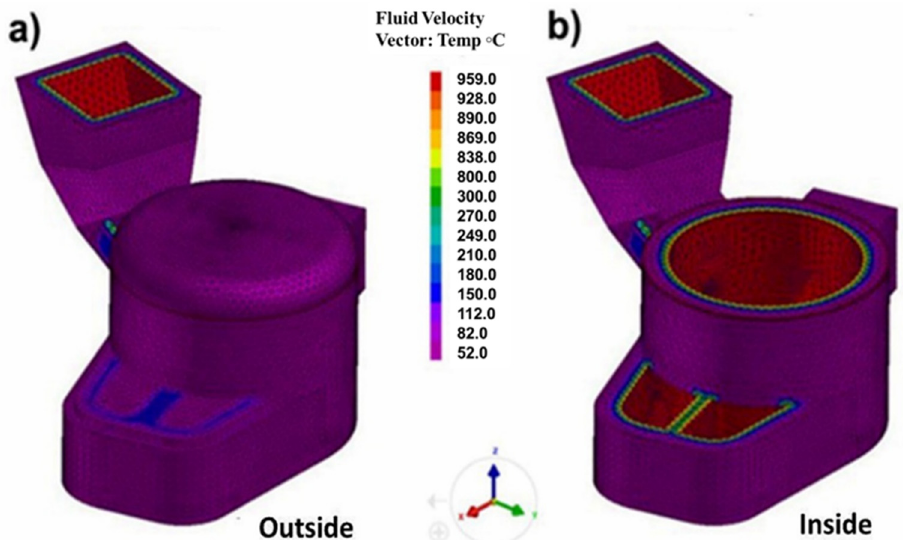
Figure 9. Temperature profiles at ( a ) the outside of the furnace, and ( b ) the inside of the furnace, after 3671 s of simulation.